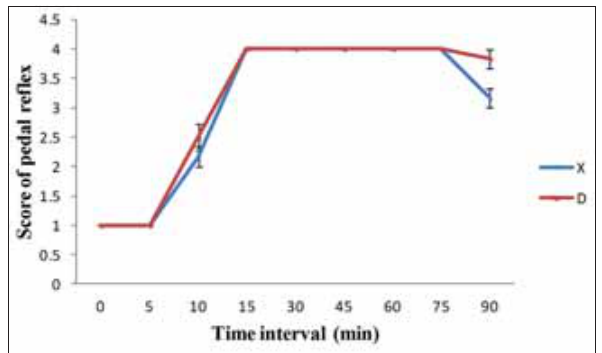
Figure-1: Mean±Standard error scores of pedal reflex in animals of different groups. *Significantly different from the base value (p<0.05). **Significantly different from the base value